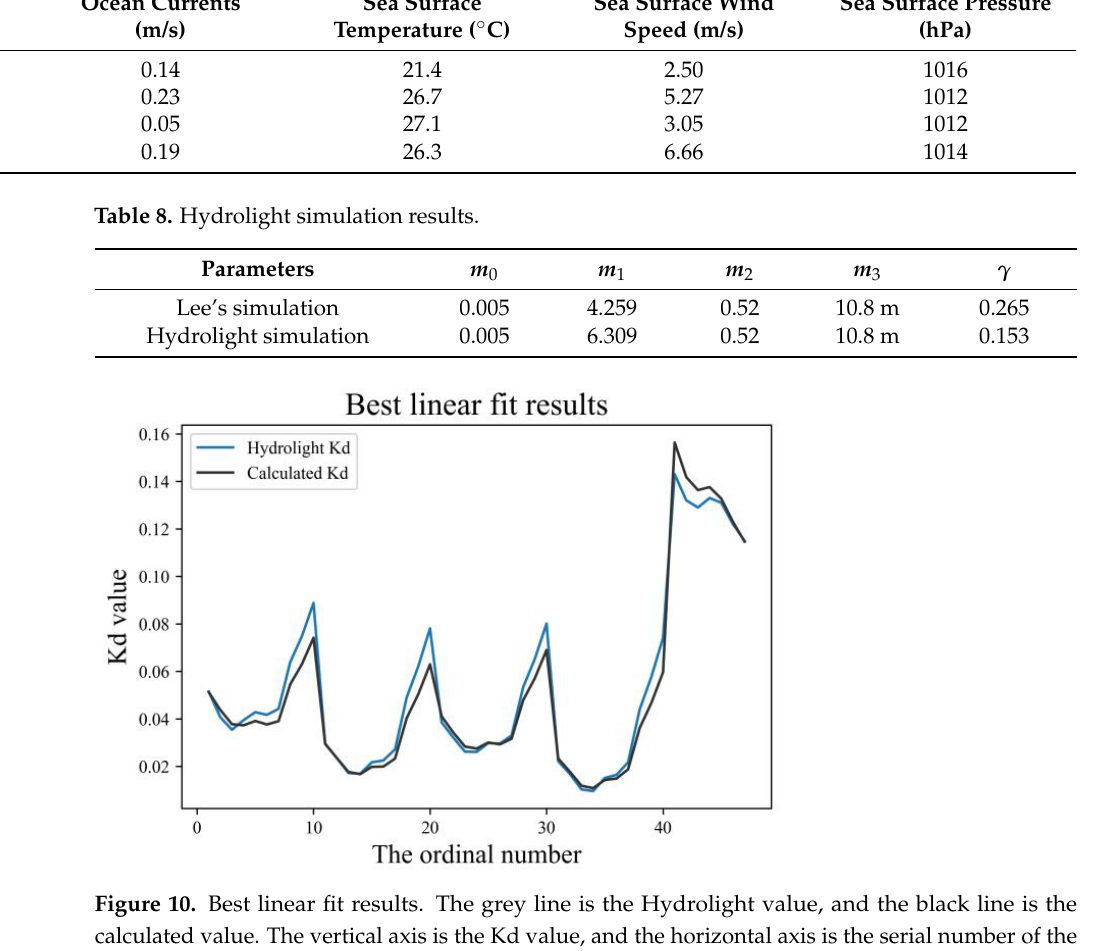
Table 9. Comparison of inversion bathymetry results of remote sensing images by different models using Wuzhizhou Island. Units: m. Wuzhizhou Island Data